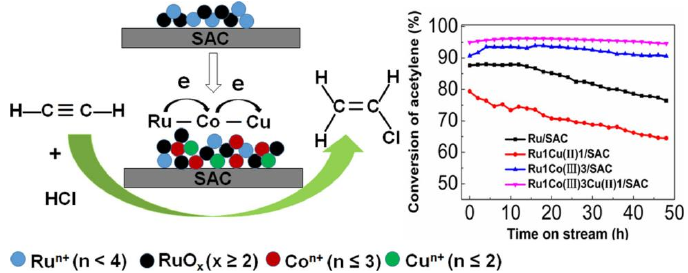
Figure 12. Ru-Co 3+ -Cu 2+ /SAC catalyst for acetylene hydrochlorination [93]. Figure 12. Ru-Co 3 + -Cu 2 + / SAC catalyst for acetylene hydrochlorination